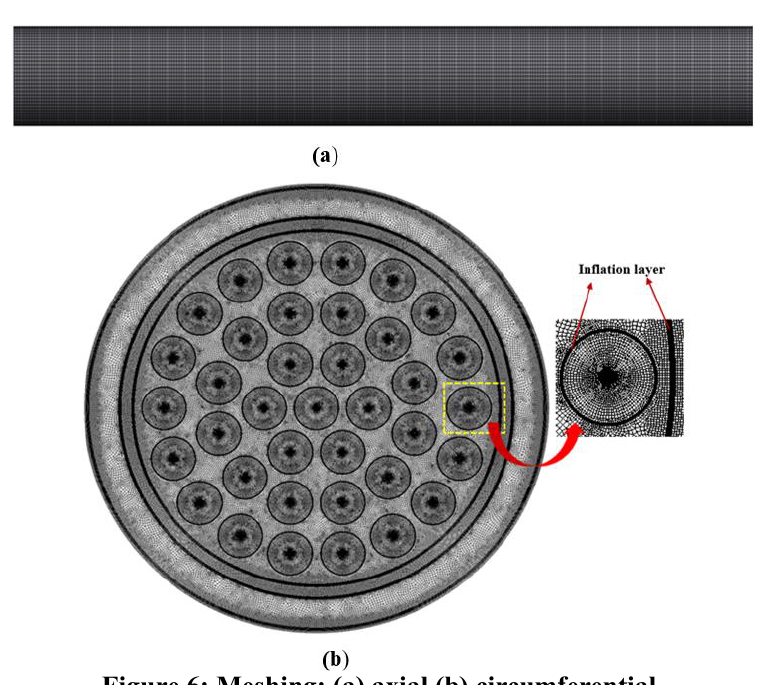
Figure 6: Meshing: (a) axial (b)